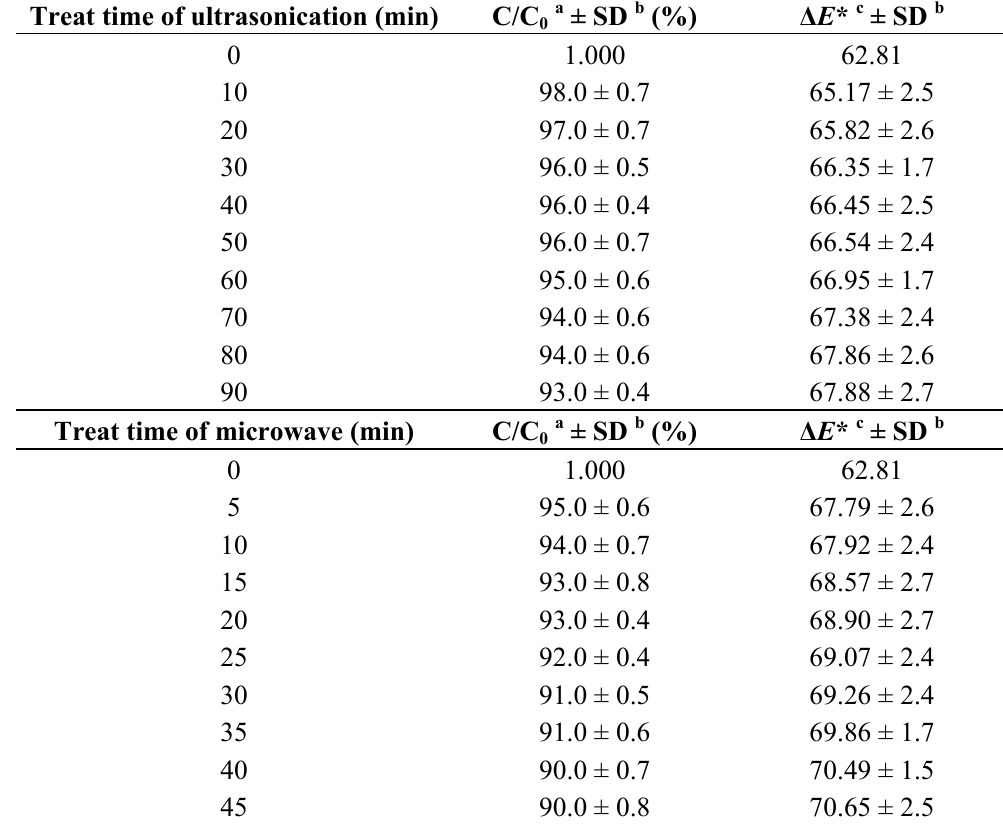
Table 5. Effect of extraction time on content and color stability of S. chinensis